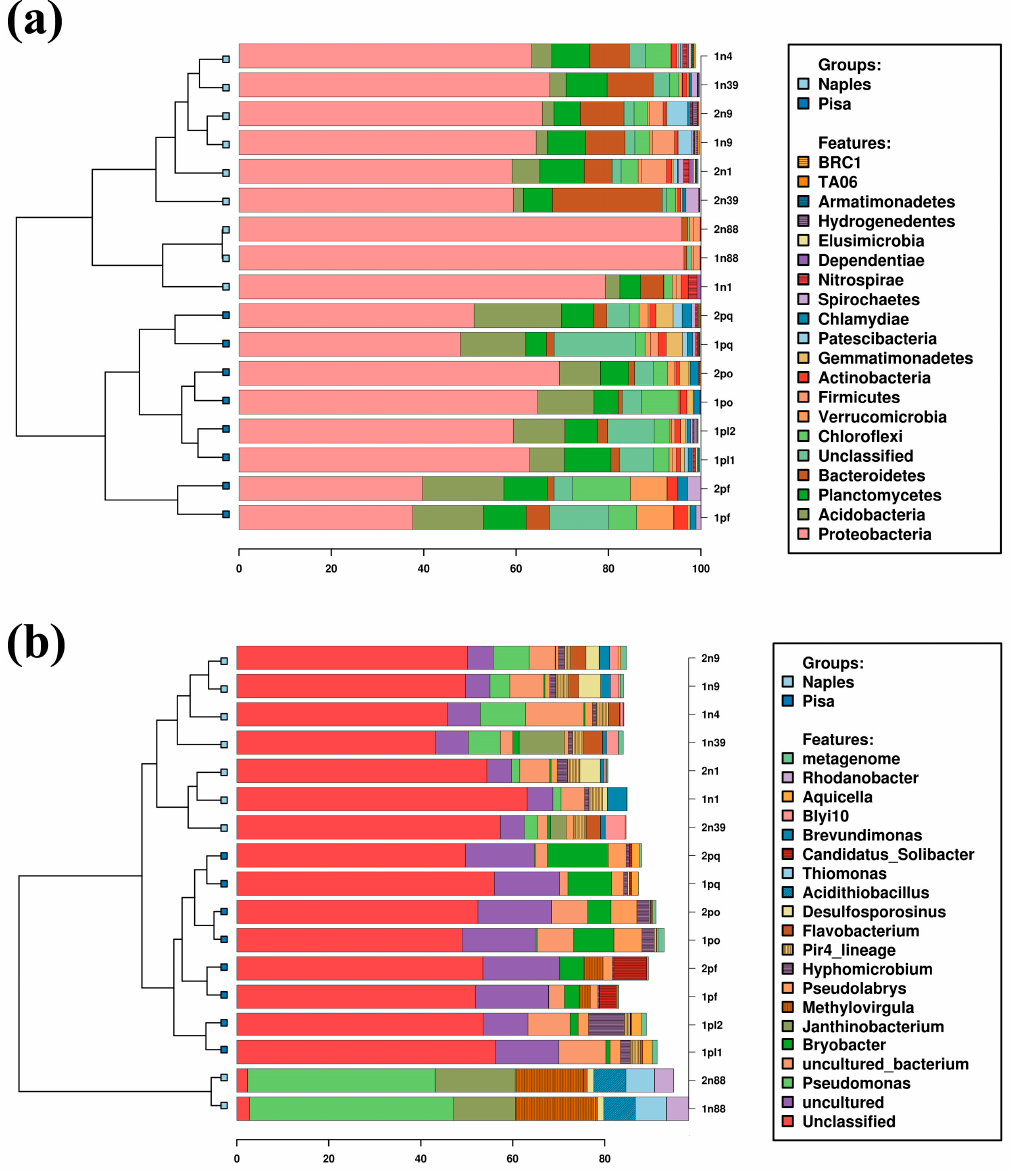
Figure 3. 16S . Stacked barcharts of the taxonomic profile at phylum ( a ) and genus ( b ) level.